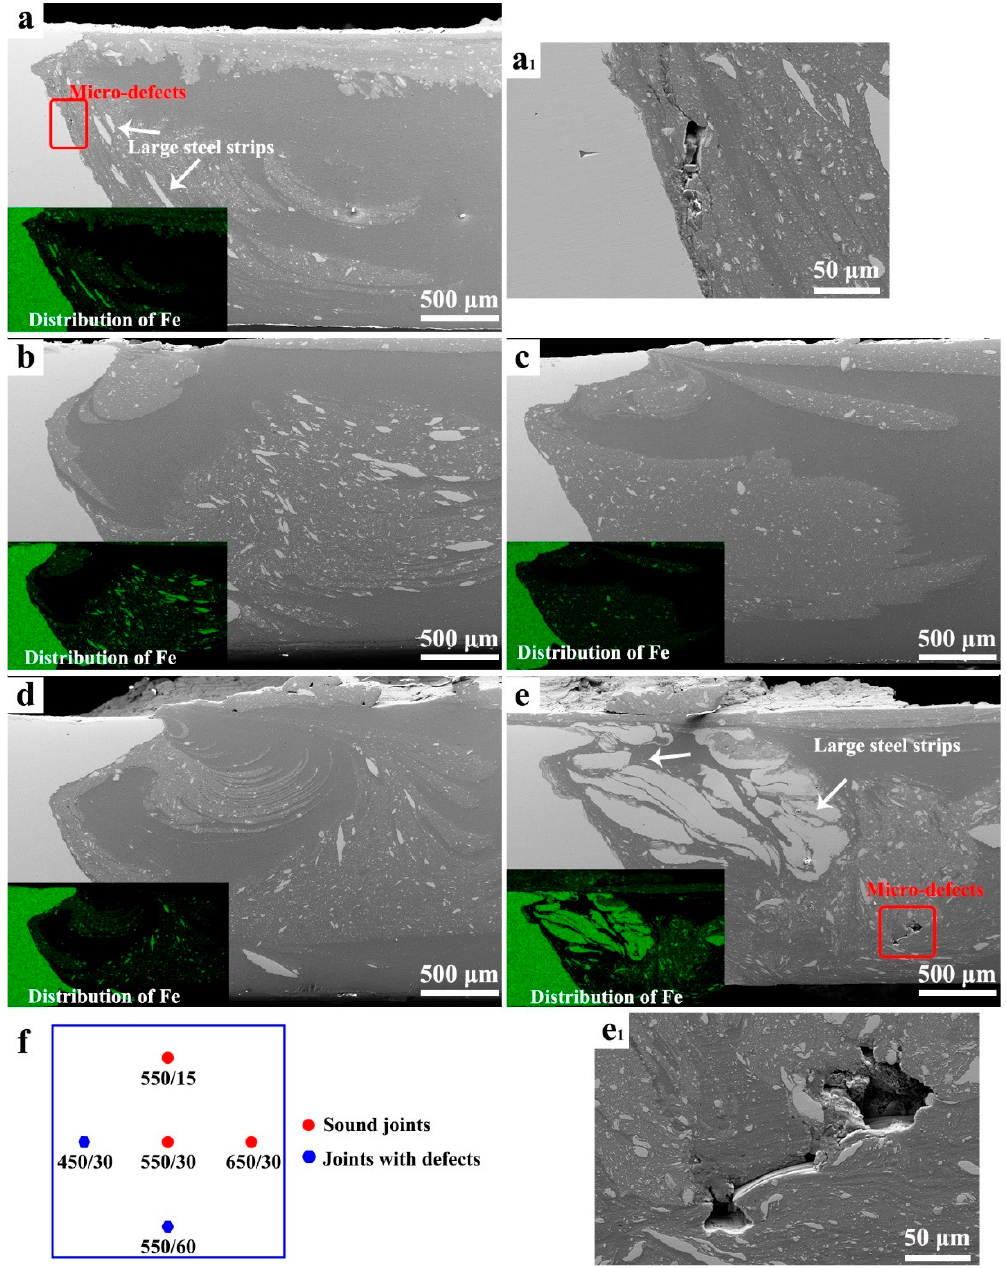
Figure 5. The morphologies in the NZs of the ( a ) 450/30, ( b ) 550/30 ( c ) 650/30, ( d ) 550/15, and ( e ) 550/60 samples detected with SEM; and the magnified images of the micro-defects in the ( a 1 ) 450/30 and ( e 1 ) 550/60 samples; ( f ) the quality of all the FSW joints. Table 2. The results of the heat index calculated in this